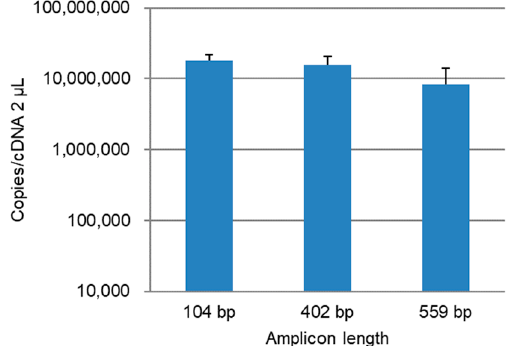
Figure 2. Quantitation of the influenza A virus PB1 gene in the lung homogenate samples. Quantifi- cation was performed twice per sample, and the average of the two samples was calculated. Error bars indicate the standard deviations.